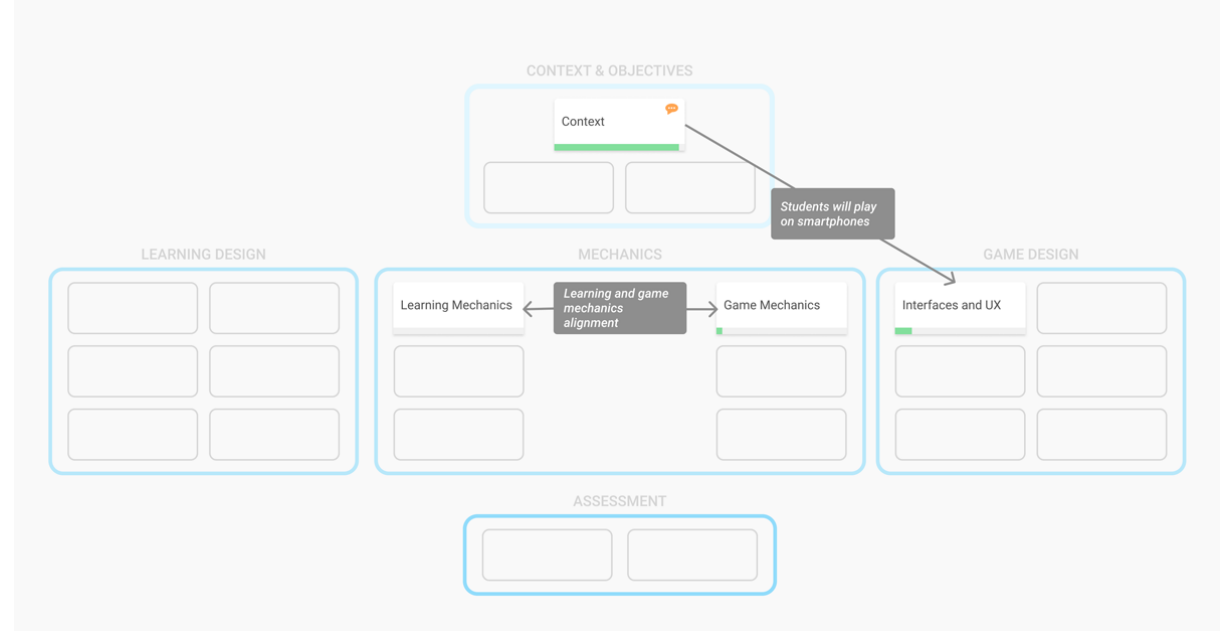
Figure 6. Causality and interdependence relationships.